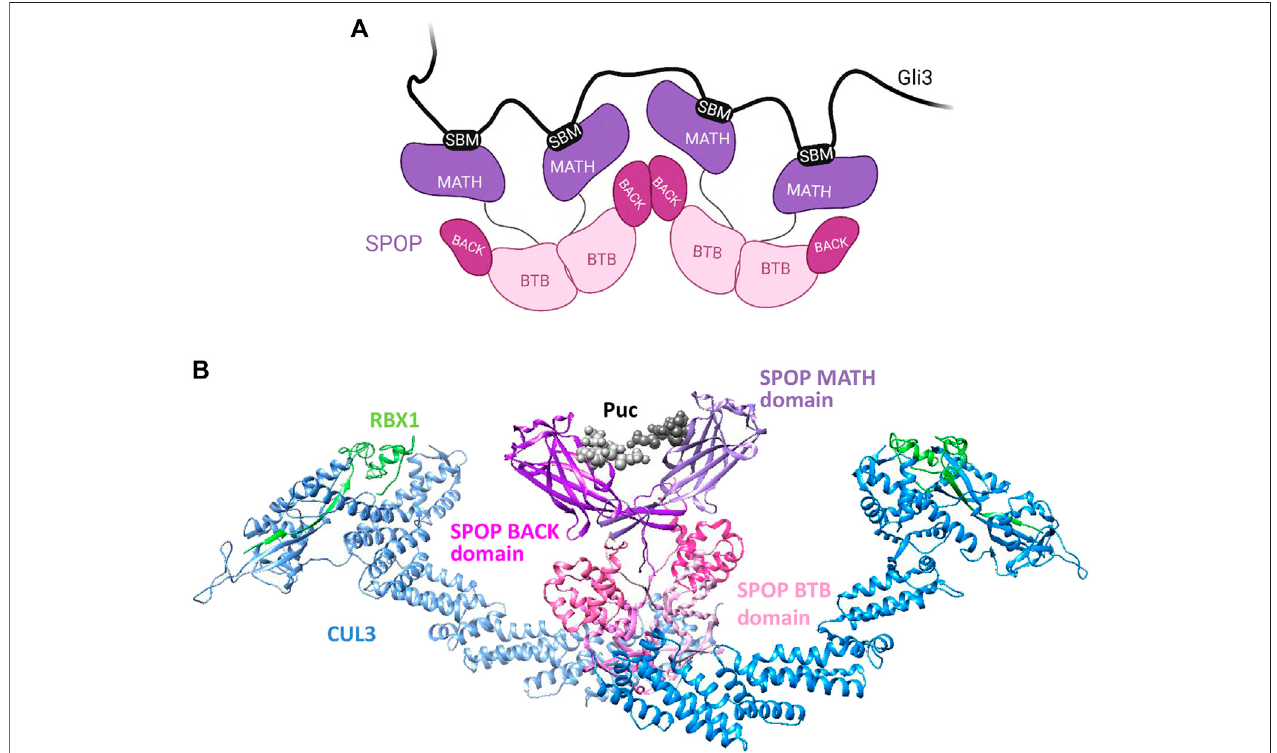
FIGURE 3 | (A) Schematic showing the oligomerization of SPOP via its BACK and BTB domains, described in Section 2.1.2 . Created with BioRender.com. (B) ModelofSPOPdimerboundtoadegronofthesubstratePuc.Theproteinsarecoloured:Cul3,blue;Rbx1,green,andPucinblack.SPOPdomainsarecoloured:MATH degron-binding domain in purple; BTB domain in pink, and BACK domain in magenta. The model was made in Chimera (https://www.rbvi.ucsf.edu/chimera) using the following PDBs, 3IVV, 4EOZ, 3HQI and 1LDJ. (Zheng et al., 2002; Zhuang et al., 2009; Ji and Privé, 2013).